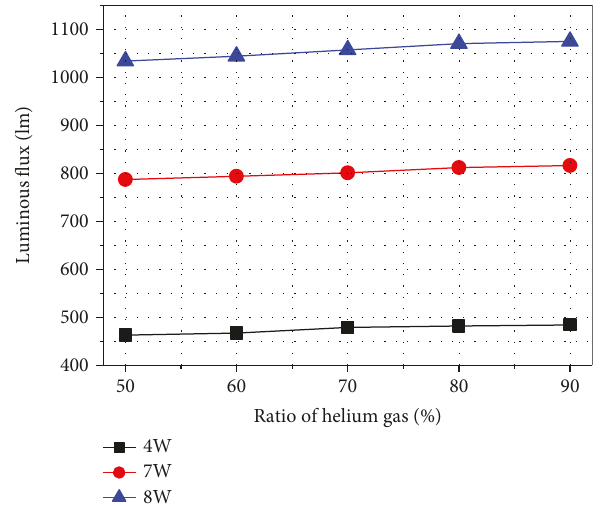
Figure 4: Luminous fl ux changed with di ff erent helium in fl ating ratios in the A60 LED fi lament lamp.